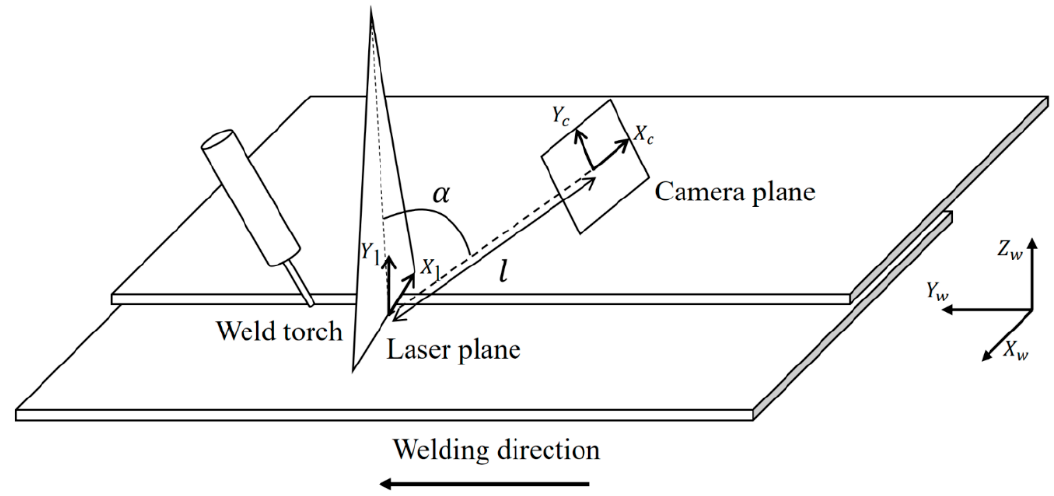
Figure 6. Coordinate systems of the laser vision system.